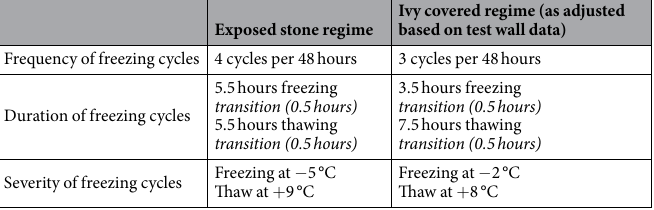
Table 3. Freezing regimes used to simulate frost weathering in the laboratory.